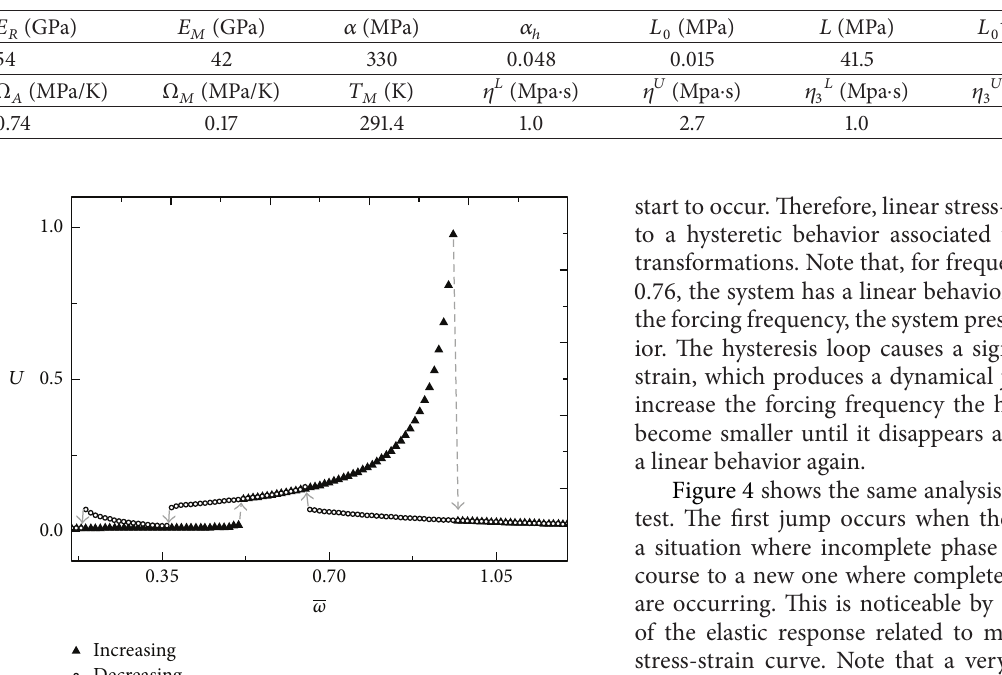
Table 1: SMA parameters.